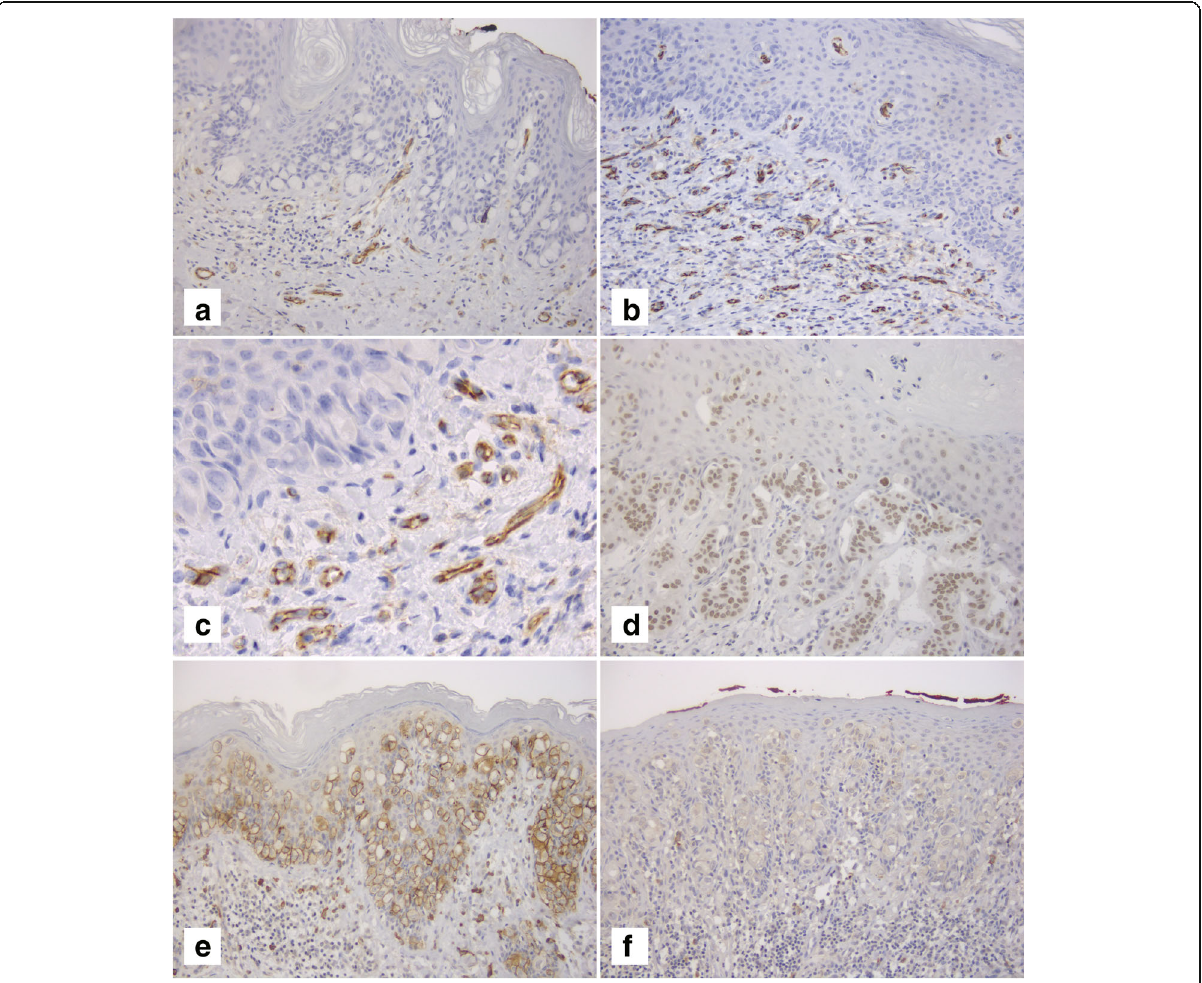
Fig. 2 a A case with a low value of HVD (microvessels are highlighted by CD31 immunostaining) (original magnification ×200); b A case with a high value of HVD (microvessels are highlighted by CD31 immunostaining) (original magnification ×200); c Same case as B (original magnification ×400); d Paget cells show positive nuclear staining for SLUG; e Positive immunostaining for N-cadherin in Paget cells (original magnification ×200); f Negative immunostaining for N-cadherin in Paget cells (original magnification